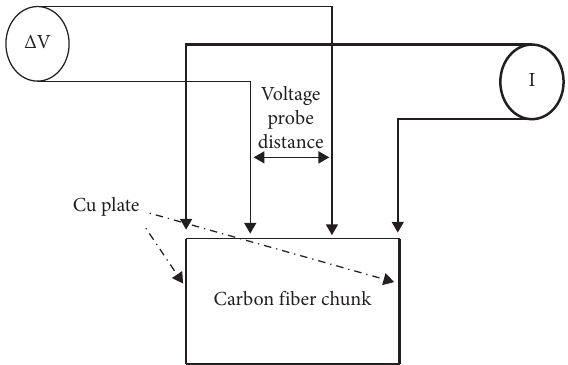
Figure 2: Schematic diagram of resistivity test by the four-probe method.